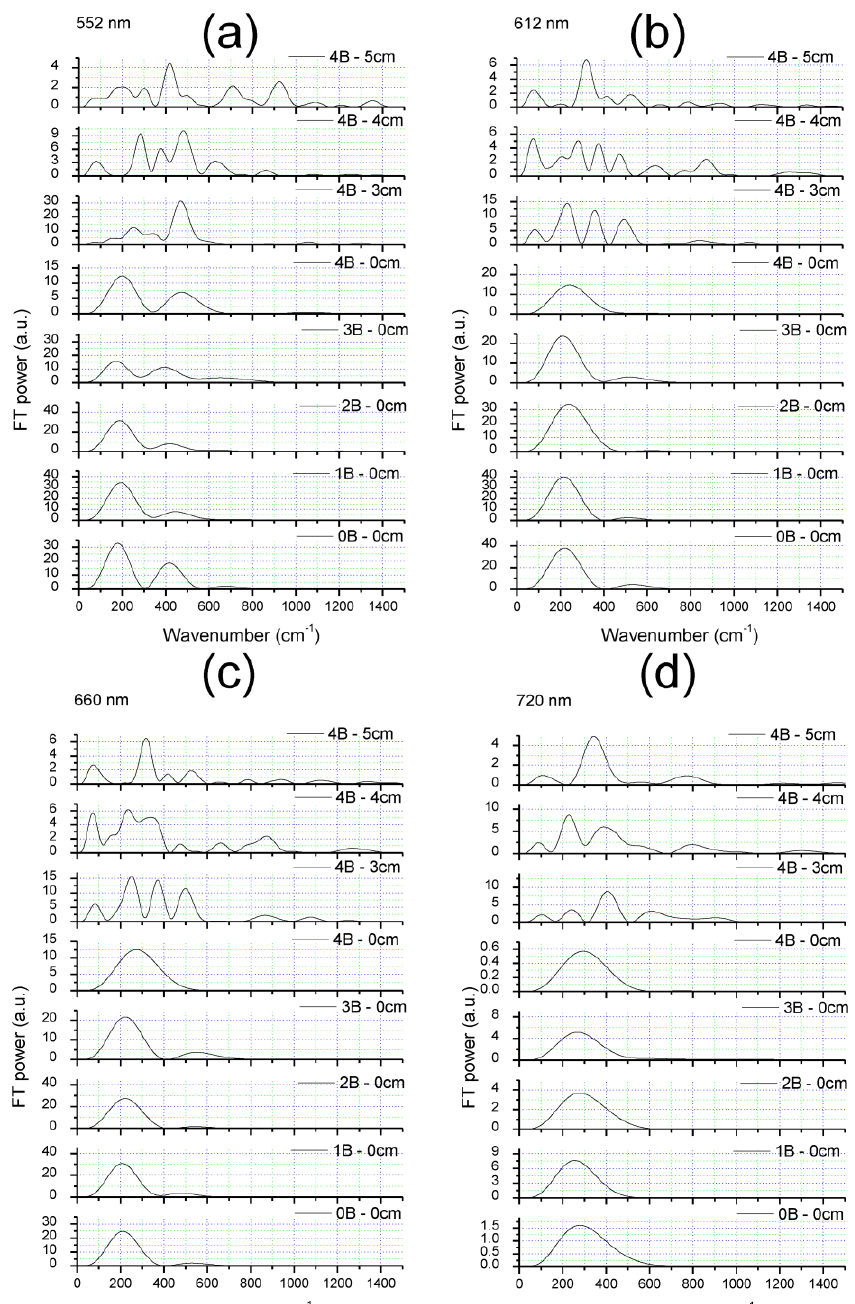
Figure 6. Panels (1) to (4) plot the Fourier transforms of the curves in Figures 5((1) – (4)). The sequence of curves from top to bottom in each panel follows those shown in Figure 5.